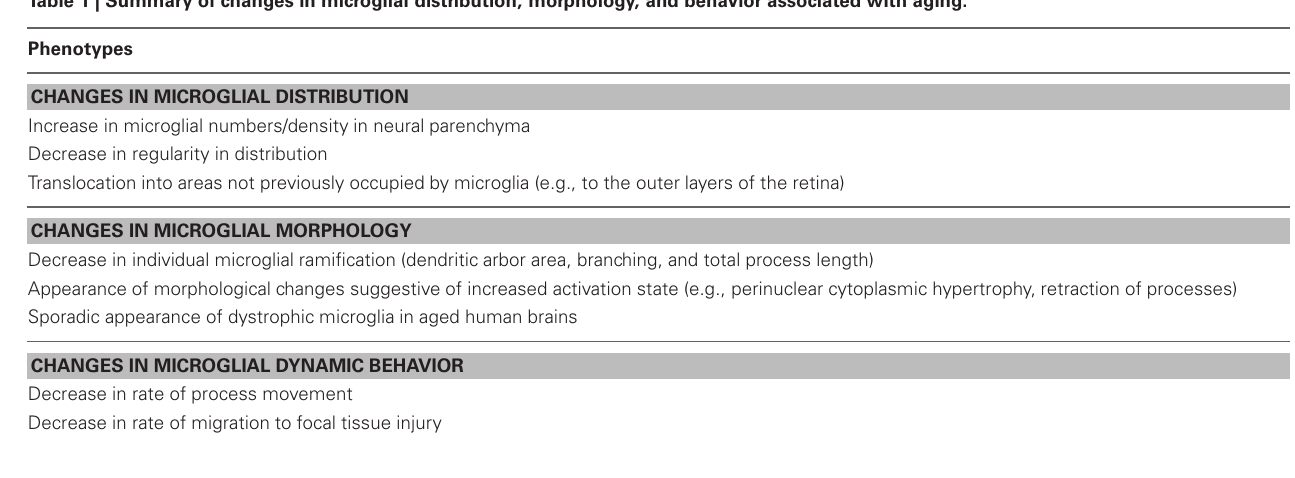
Table 1 | Summary of changes in microglial distribution, morphology, and behavior associated with